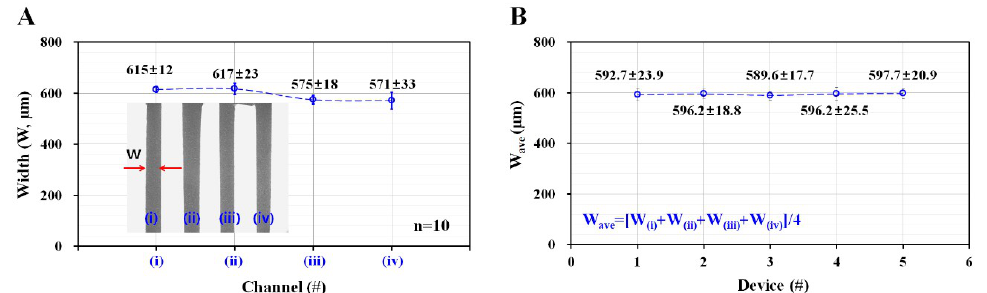
Figure 3. Quantitative measurement of width variations of four microfluidic channels fabricated by using an adhesive sheet for master mold. ( A ) Variations of channel width for four individual channels. ( B ) Variations of averaged channel width for five different devices.